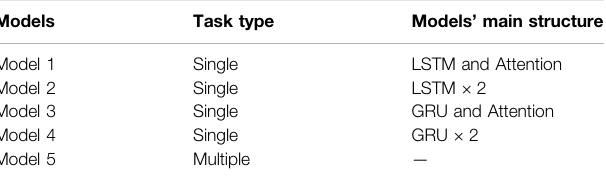
TABLE 2 | The main structure of models. TABLE 3 | Comparison of prediction errors of training sets with different days.